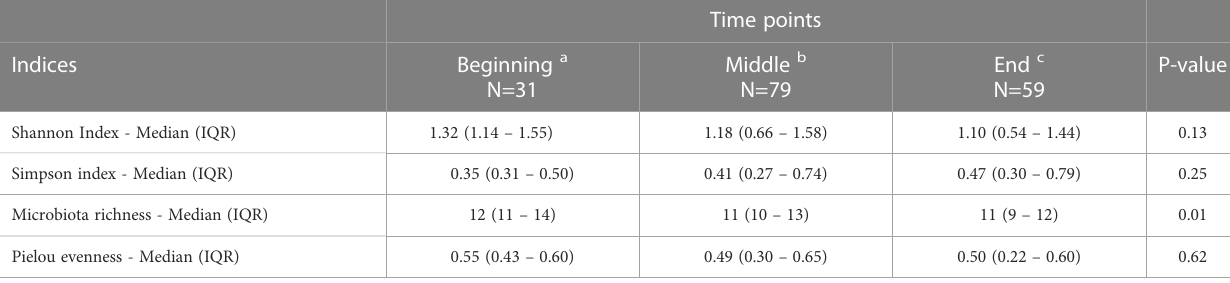
TABLE 3 Microbiome diversity measurements across the three